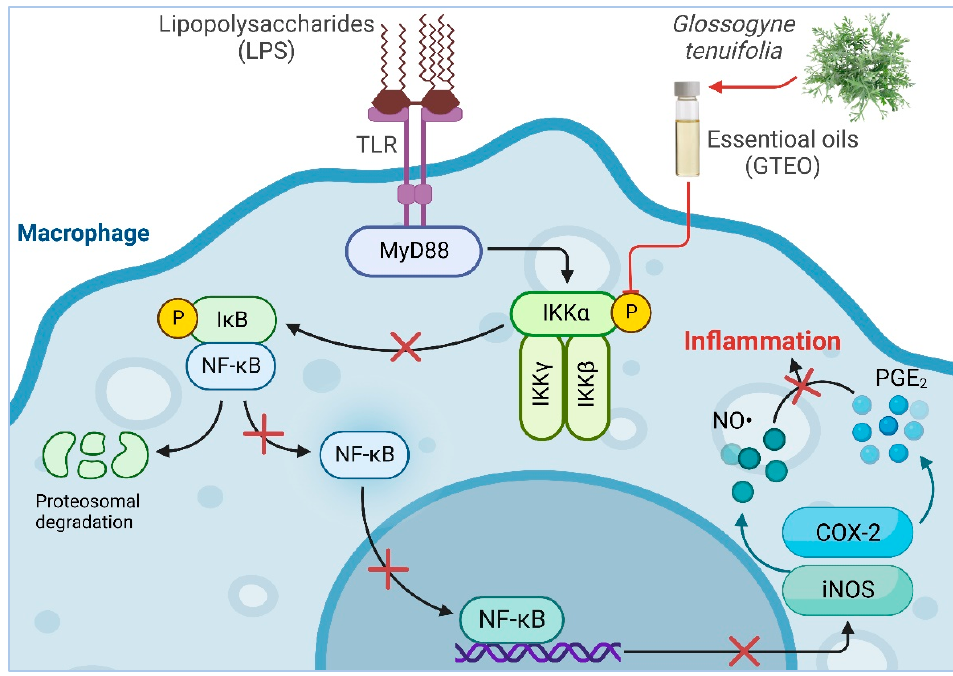
Figure 6. The schematic representation illustrates GTEO’s anti-inflammatory properties.